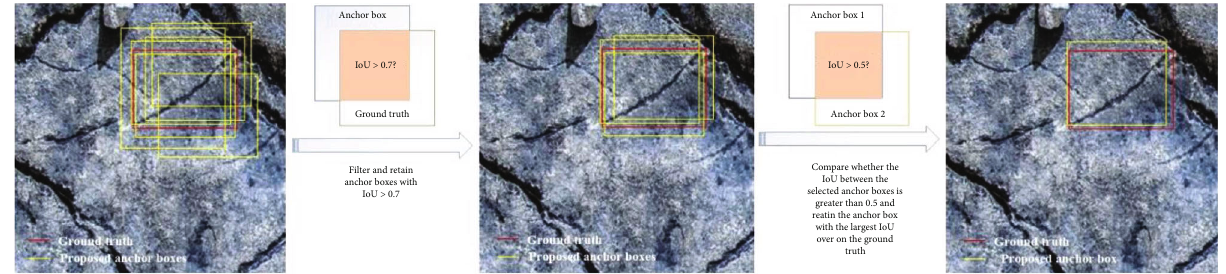
Figure 9: Diagram of selecting proper anchors based on the IoU